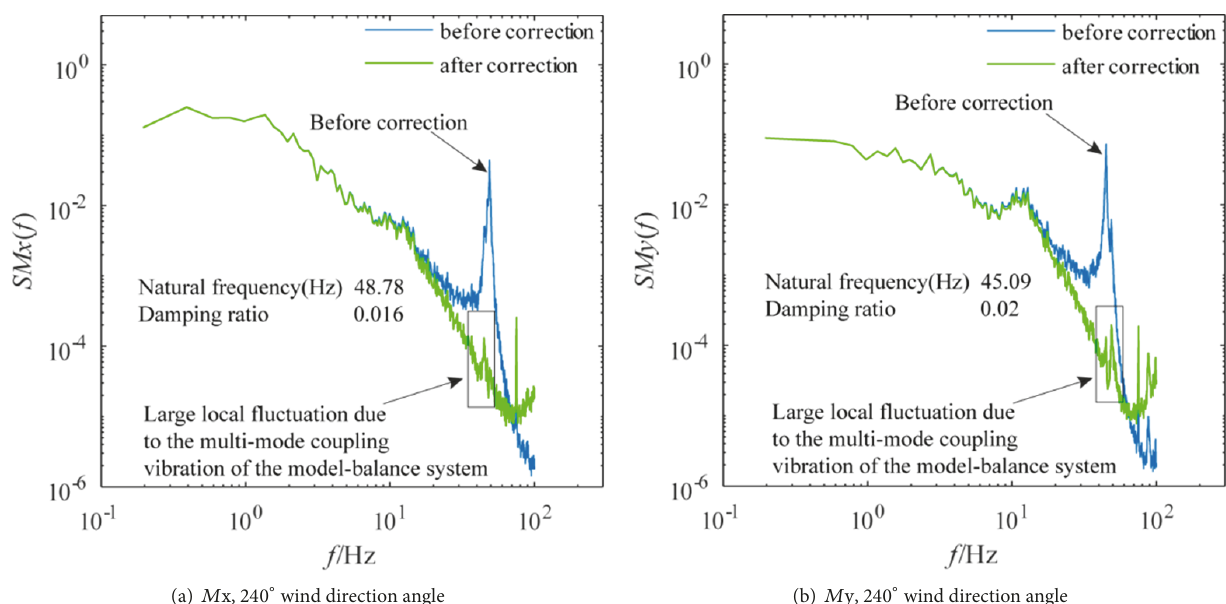
Figure 10: The correction effect of the base overturning moment of Guangzhou East Tower at 240 ∘ wind direction angle before decoupling.